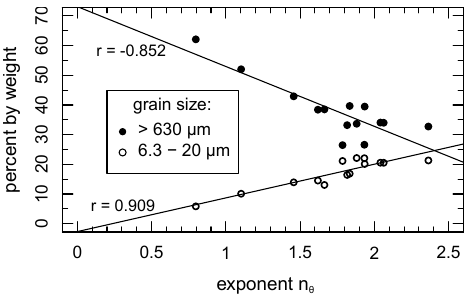
Figure 2. Exponent n θ in dependence of different grain sizes. Table 3. Fitted water content formation factor ( F θ ), water con- tent exponent ( n θ ) and mean squared error for ρ eff /ρ w (MSE) for Eqs. (1)–(3) of the two different depth ranges. Depth range